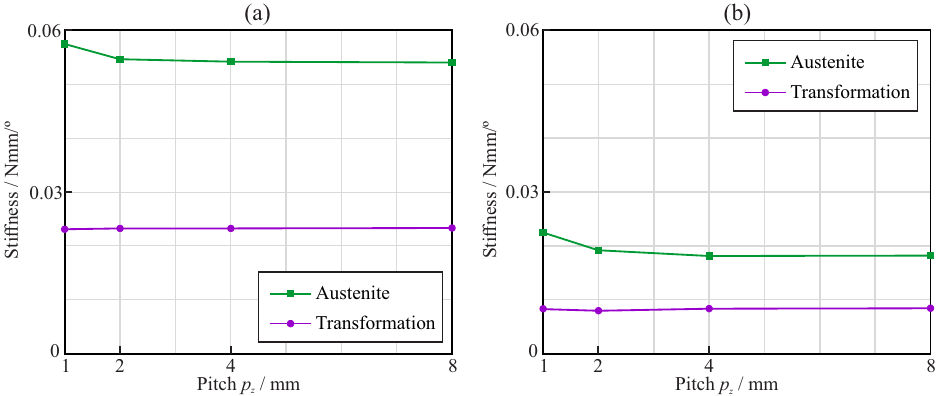
Figure 13. Torsional analysis: torsion stiffness of the endodontic rotary files with ( a ) square and ( b ) triangular